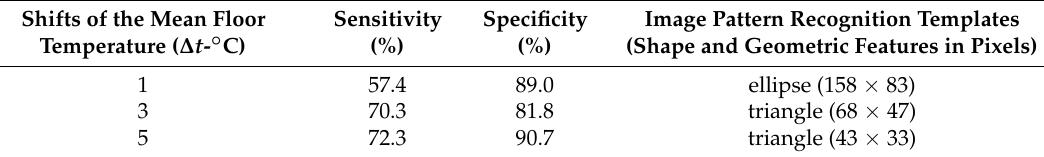
Table 4. Detection performances, reached during the setup procedure (step B), reported for each mean temperature shift investigated (i.e., 1, 3, and 5 ◦ C). In this elaborations, a defined cutoff level was used